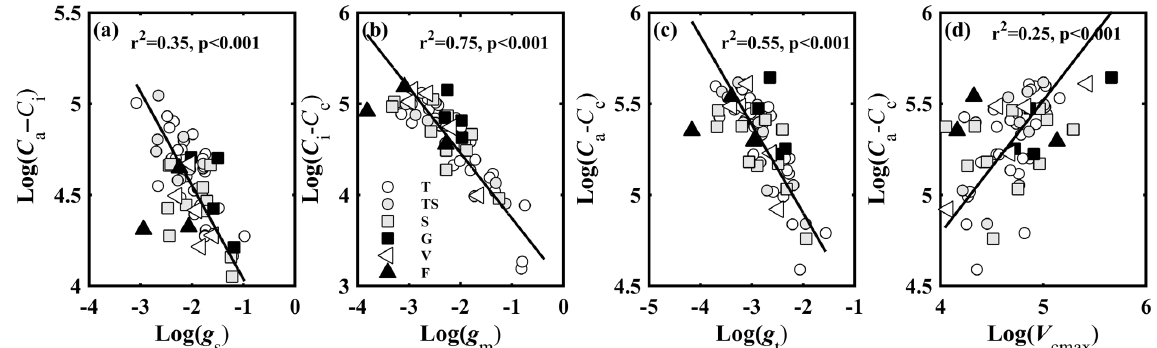
Figure 1. Relationships between (a) CO 2 gradient between ambient air and intercellular air space ( C a – C i , µmol mol − 1 ) and stomatal conductance to CO 2 ( g s , molCO 2 m − 2 s − 1 ) ; (b) CO 2 gradient between intercellular air space and chloroplasts ( C i – C c , µmolmol − 1 ) and mesophyll conductance to CO 2 ( g m , molCO 2 m − 2 s − 1 ) ; (c) CO 2 concentration gradient between ambient air and chloroplasts ( C a – C c , µmolmol − 1 ) and total conductance to CO 2 ( g t , molCO 2 m − 2 s − 1 ) ; and (d) C a – C c and the maximum carboxylase activity of Rubisco ( V cmax , µmolCO 2 m − 2 s − 1 ) . Lines refer to regression line for 63 species. T, TS, S, G, V, and F represent tree, tree/shrub, shrub, grass, vine, and fern,